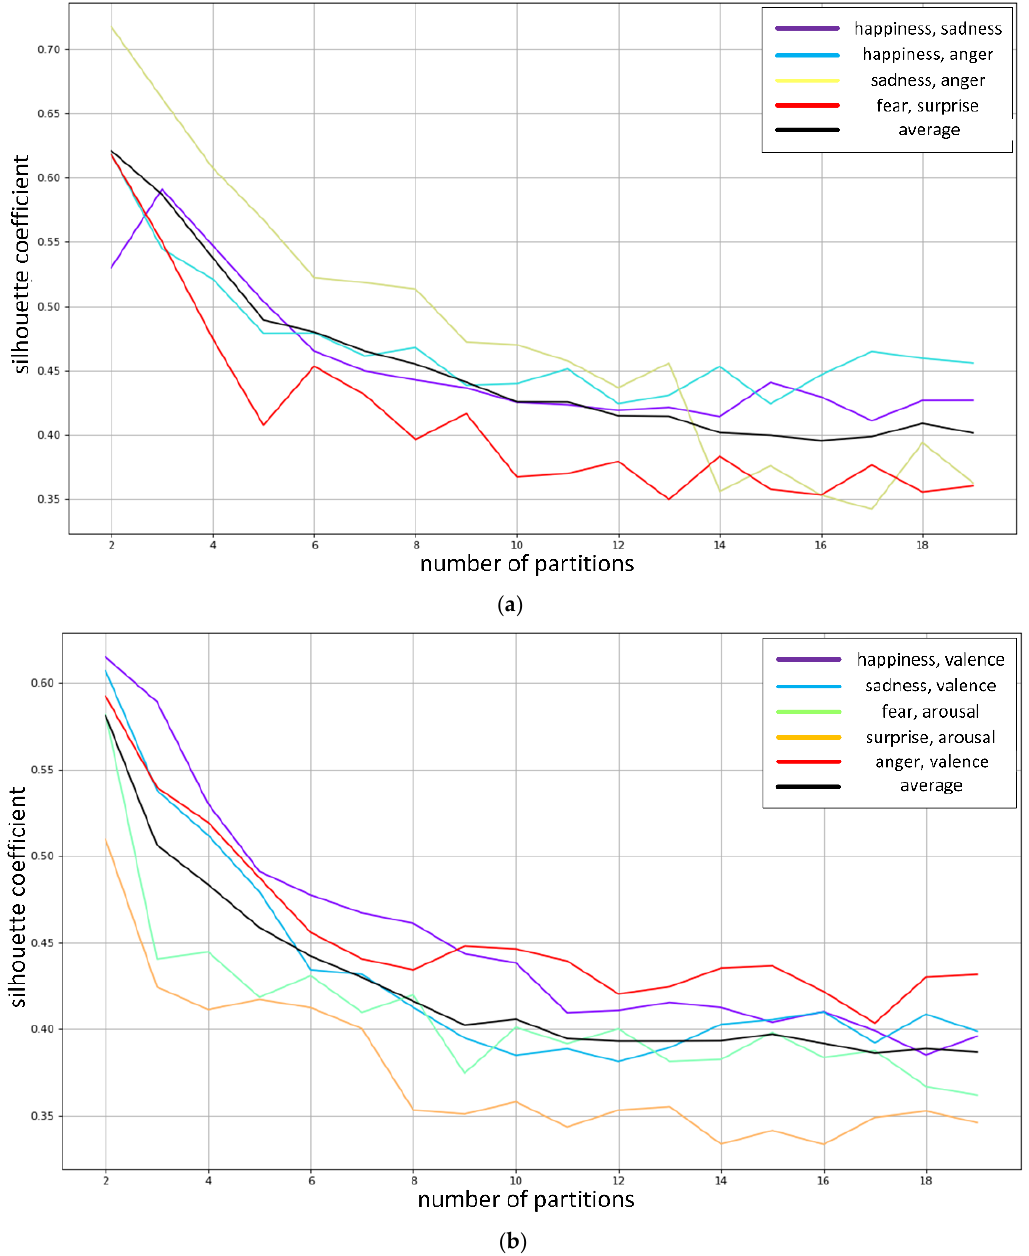
Figure 8. Silhouette plots in interval k = 2 – 19 for: ( a ) pairs of emotion norms {happiness, sadness}, {happiness, anger}, {sadness, anger}, {fear, surprise}; ( b ) tuples of emotion norms and emotion dimensions {happiness, valence}, {sadness, valence}, {fear, arousal}, {surprise, arousal}, {anger, valence}.